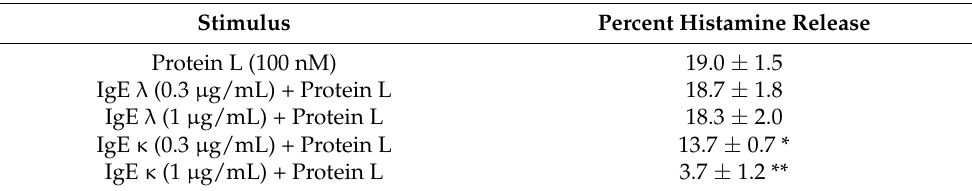
Table 4. Effects of preincubation of protein L with human monoclonal IgE λ or IgE κ on the activation of